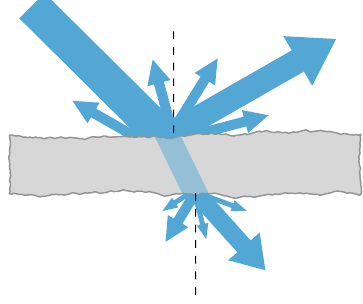
Figure 5. Light interacting with rough